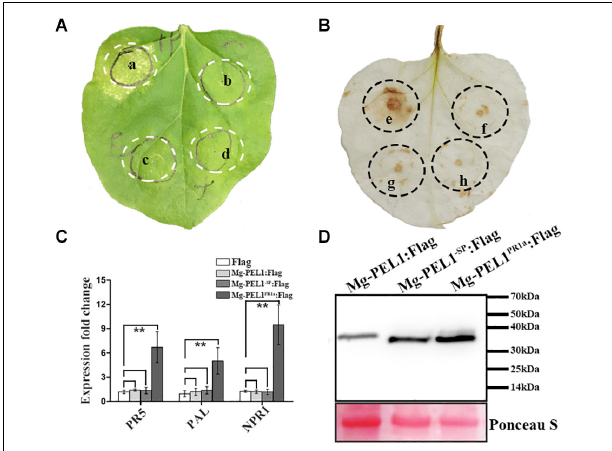
FIGURE 8 | Cell wall localization of Mg-PEL1 is required for the activation of plant defenses. (A) Mg-PEL1 triggered cell death in Nicotiana benthamiana . Agrobacterium strain GV3101 carrying constructs Mg-PEL1 PR1a : Flag (a), Mg-PEL1 - SP : Flag (b), Mg-PEL1: Flag (c) and Flag (d) were transiently expressed in N. benthamiana leaves. At 5 d after infiltration, infiltrated sites were taken photos for cell death phenotype analysis. (B) Mg-PEL1 induced hydrogen peroxide production in N. benthamiana . Agrobacterium strain GV3101 carrying constructs Mg-PEL1 PR1a : Flag (e), Mg-PEL1 - SP : Flag (f), Mg-PEL1: Flag (g) and Flag (h) were transiently expressed in N. benthamiana leaves. At 2 d after infiltration, hydrogen peroxide production in infiltrated leaves was detected by DAB staining. (C) Mg-PEL1 induced the expression of defense related genes in N. benthamiana . The transcript levels of three defense response genes PR-5 , PAL and NPR1 were measured in N. benthamiana leaves at 2 d after infiltration with Mg-PEL1 - SP :Flag, Mg-PEL1:Flag, Mg-PEL1 PR1a :Flag and Flag constructs. All data revealed normal distribution and homogeneity of variance. One-way ANOVA Dunnett’s t -tests, * P < 0.05; ** P < 0.01. (D) Western blotting confirmed the expression of Mg-PEL1 - SP : Flag, Mg-PEL1: Flag and Mg-PEL1 PR1a : Flag